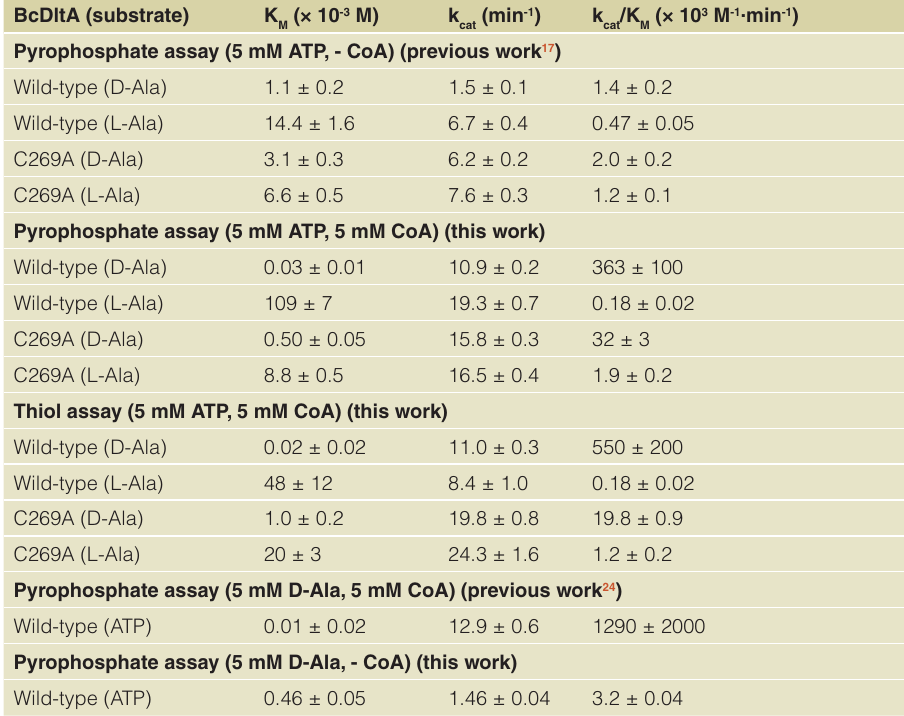
Table 2. Kinetic data for DltA protein from B. cereus